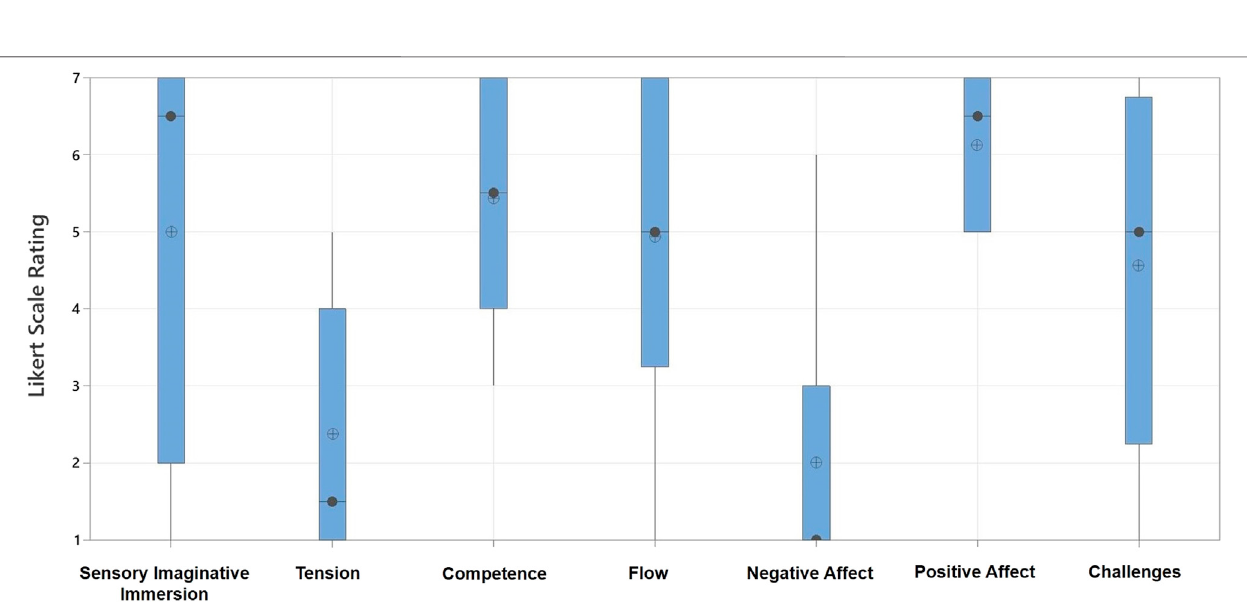
Frontiers in Computer Science |